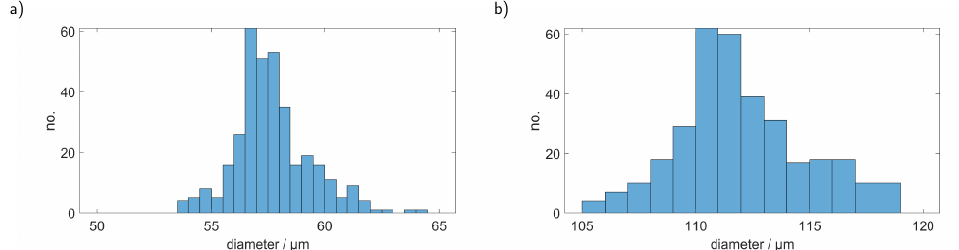
Figure 11. Determined sizes of PMMA particles with a diameter of 101 µm with ( a ) the original PS calibration curve and ( b ) with the PMMA curve that was corrected according to the simulation and the single calibration point with the 50.7 µm PS